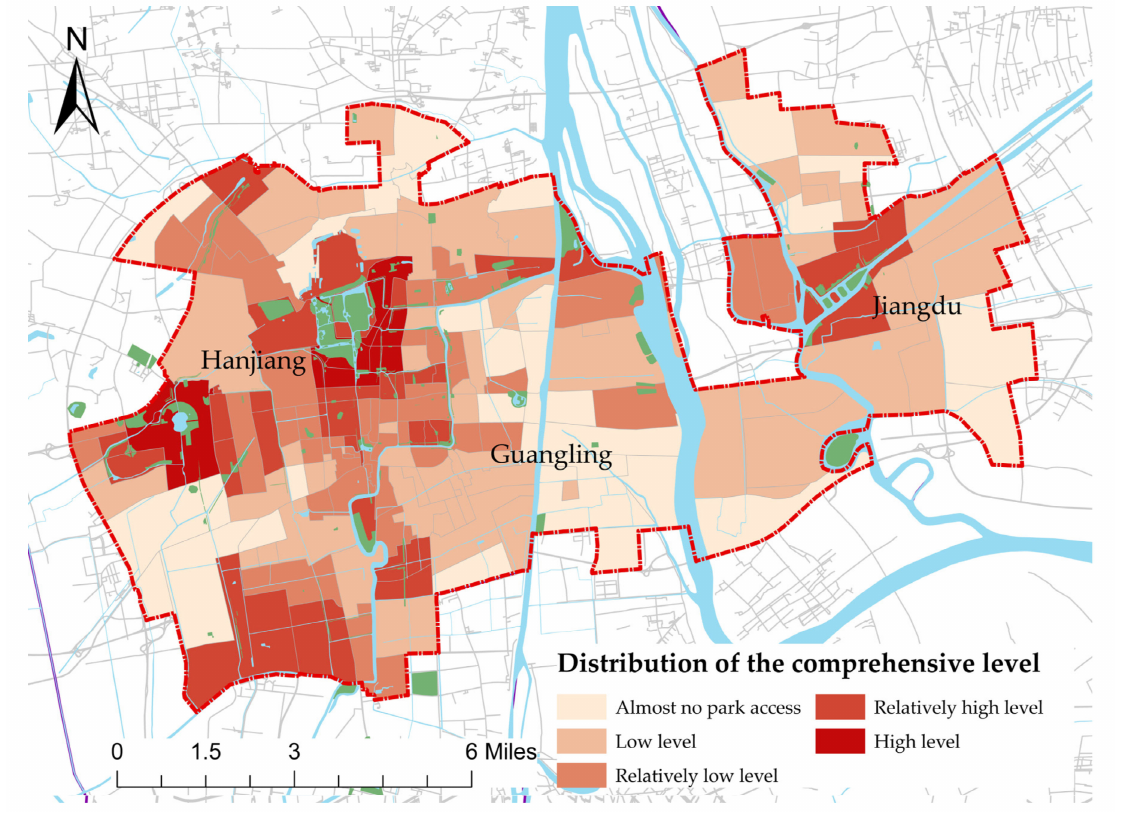
Figure 7. Distribution of the comprehensive level. Table 7. Descriptive statistics of the comprehensive